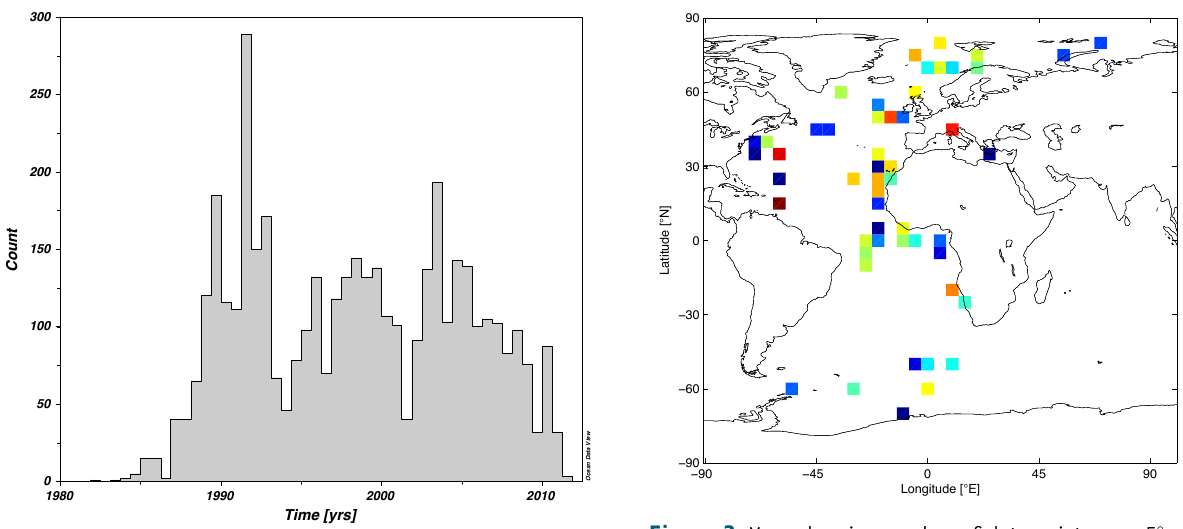
Figure 3. Map showing number of data points on a 5 ◦ × 5 ◦ grid (log 10 -scale